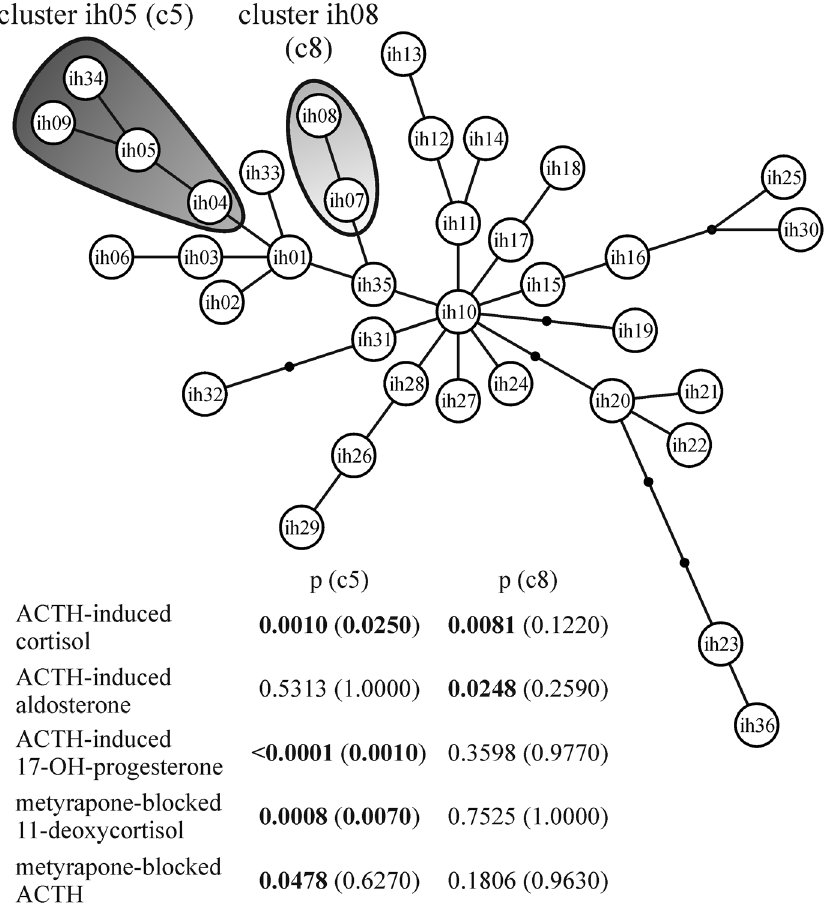
Figure 1. Haplotype tree of CYP21A2 intron 2 and the 5 9 -part of exon 3, and the CYP21A2 haplotype clusters with multiple significances found by tree scanning, and p-values of the haplotype clusters related to different steroid hormone levels in subjects with non-functioning adrenal incidentaloma. Circles represent the CYP21A2 intron 2 and the 5 9 -part of exon 3 haplotypes, lines with or without small black circles indicate the allele differences (character-state changes) between haplotype variants and gray shapes encompass the haplotype clusters with multiple significances. The values without parentheses are uncorrected p-values, and the values with parentheses are the corrected step-down permutational p-value after enforcing monotonicity. ACTH – adrenocorticotrophic